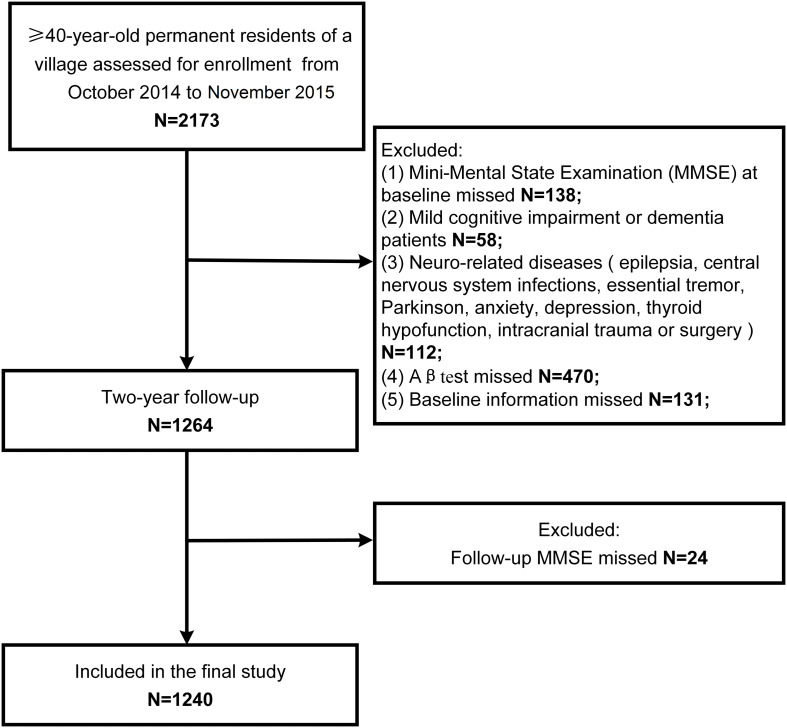
Study population screening process.